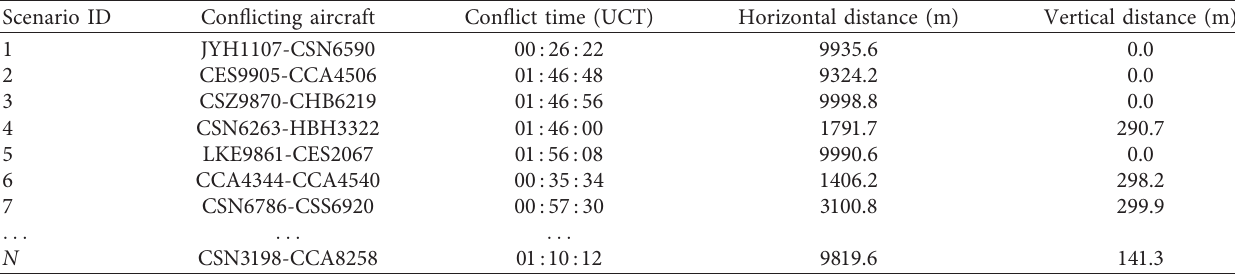
Table 1: The scenario information for the pairwise conflicts (partial).